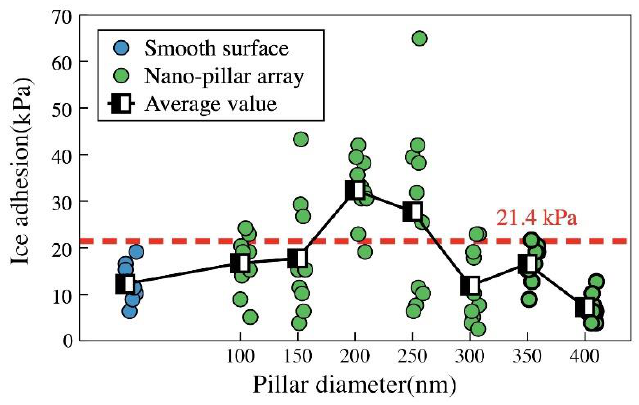
Figure 7. Ice adhesion of the hydrophobic nano-pillar array-fluoridated epoxy (1 wt %).